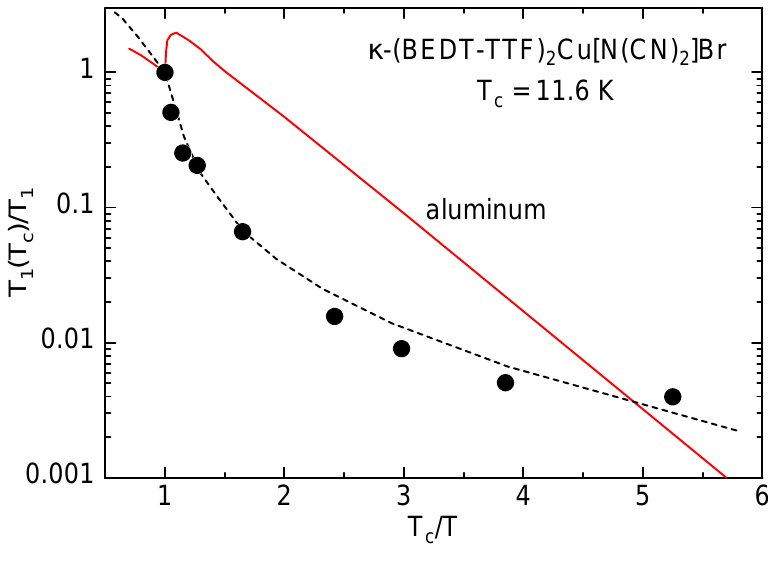
Figure 8. Temperature dependence of the normalized spin-lattice relaxation rate. The solid line depicts the behavior for the BCS superconductor aluminum [56]. Data from 13 C NMR for (cid:20) -(BEDT-TTF) Cu[N(CN) ]Br in fields parallel to the conducting ET planes are shown 2 2 as closed circles [41] and dashed line [42]. There is no Hebel–Slichter peak just below T and the relaxation rate decreases as T 3 rather then